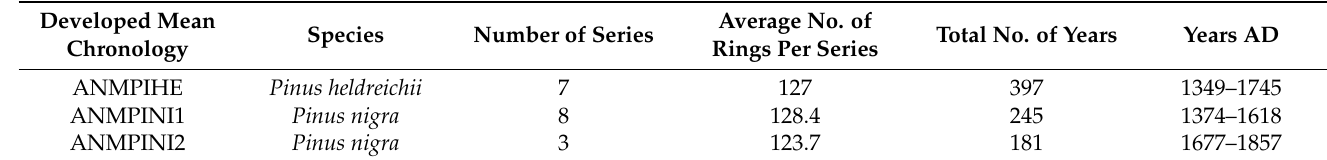
Table 3. Mean chronologies developed for the two pine species from historical timber from the Monastery of St.